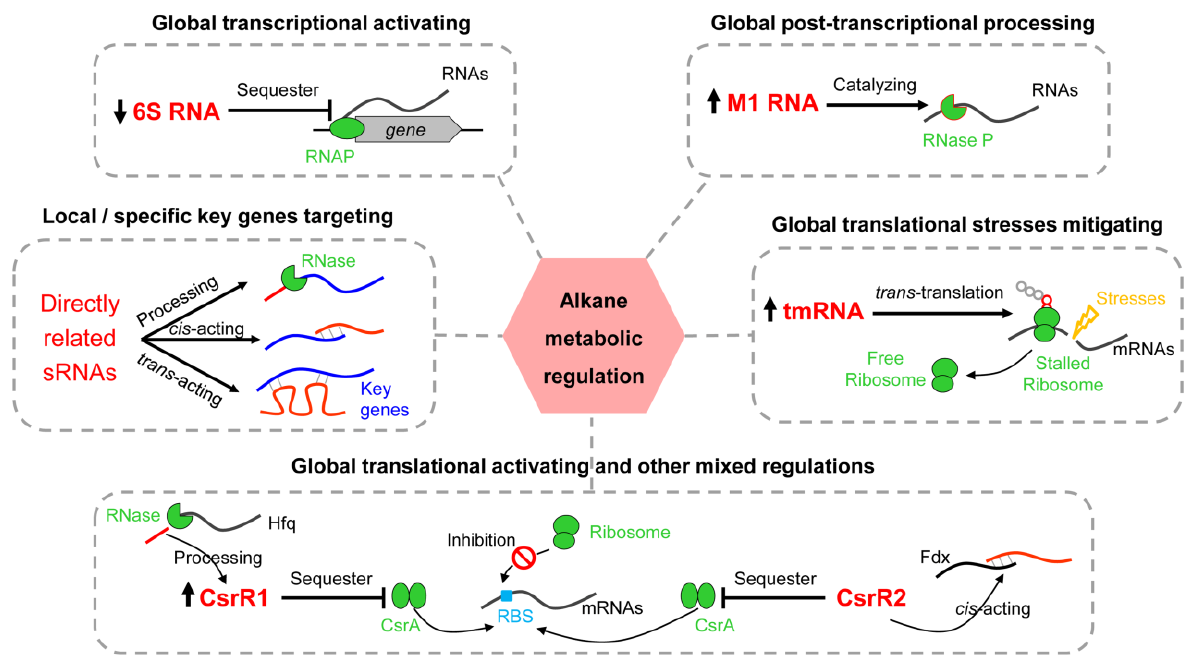
Figure 9. Hypothesized sRNA-mediated alkane metabolic regulations in A. dieselolei B-5. The key related sRNAs (red and largest font) and their potential regulating mechanisms are shown in each dotted box. The significant expression changed sRNAs responding to the alkane, which are marked with up and down arrows before them, representing up- and down-regulated expressions, respectively. The possible regulating effects of the sRNAs are indicated above each dotted box (black and bold font). Abbreviations: RNAP, RNA polymerase; Hfq, Host factor; Fdx, Ferredoxin; RBS, ribosome binding site.